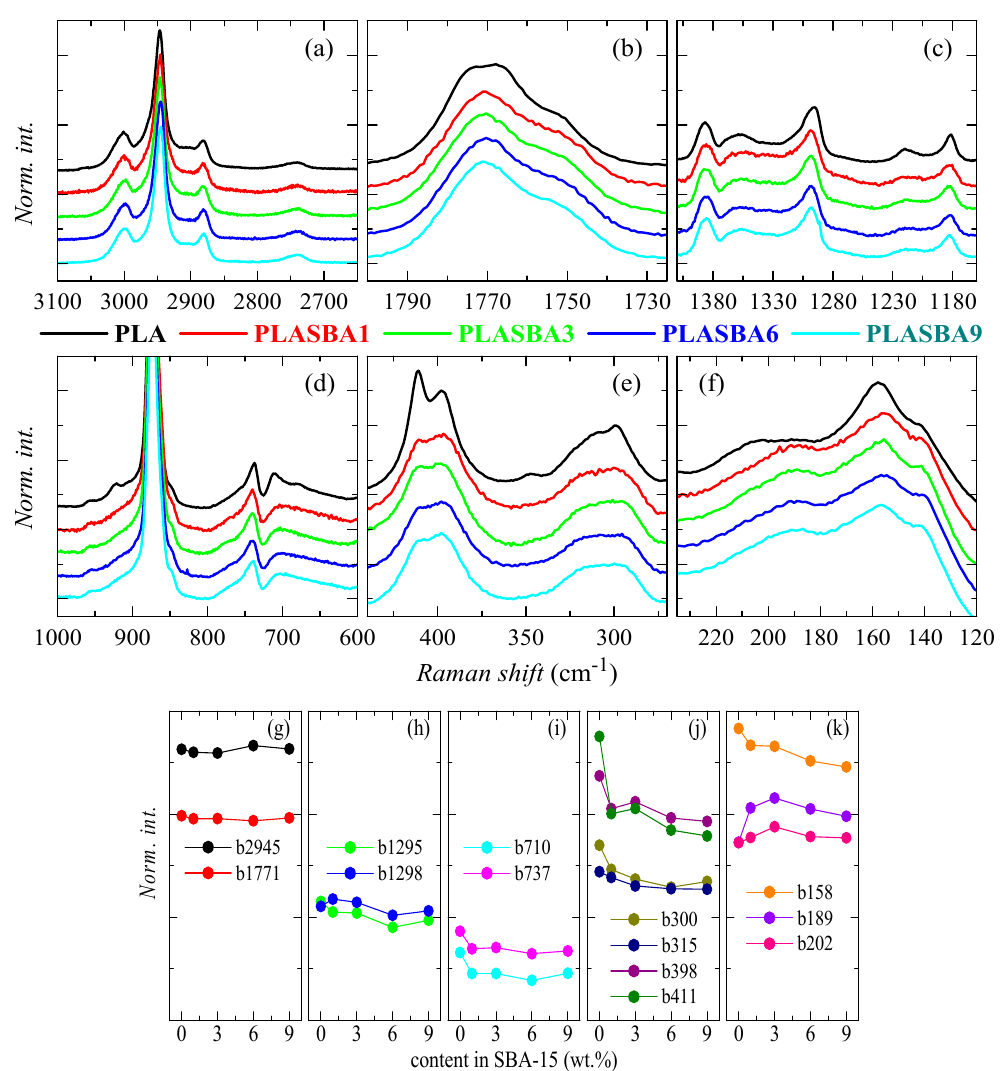
Figure 3. ( a – f ): Raman spectra for pristine PLA and its composites with mesoporous SBA-15 at different spectral regions; ( g – k ): variation with the SBA-15 content of the normalized intensity of the indicated bands.